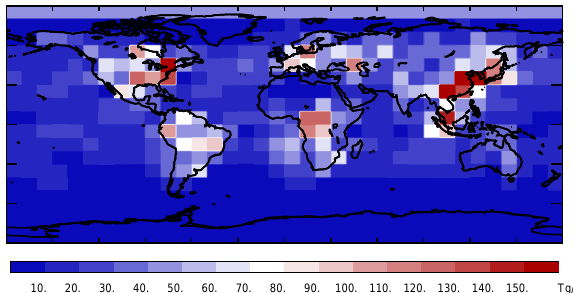
Fig. 8. Flux uncertainties (1 σ ) for the annual CO 2 flux at 10 6 km 2 as a result of transport model